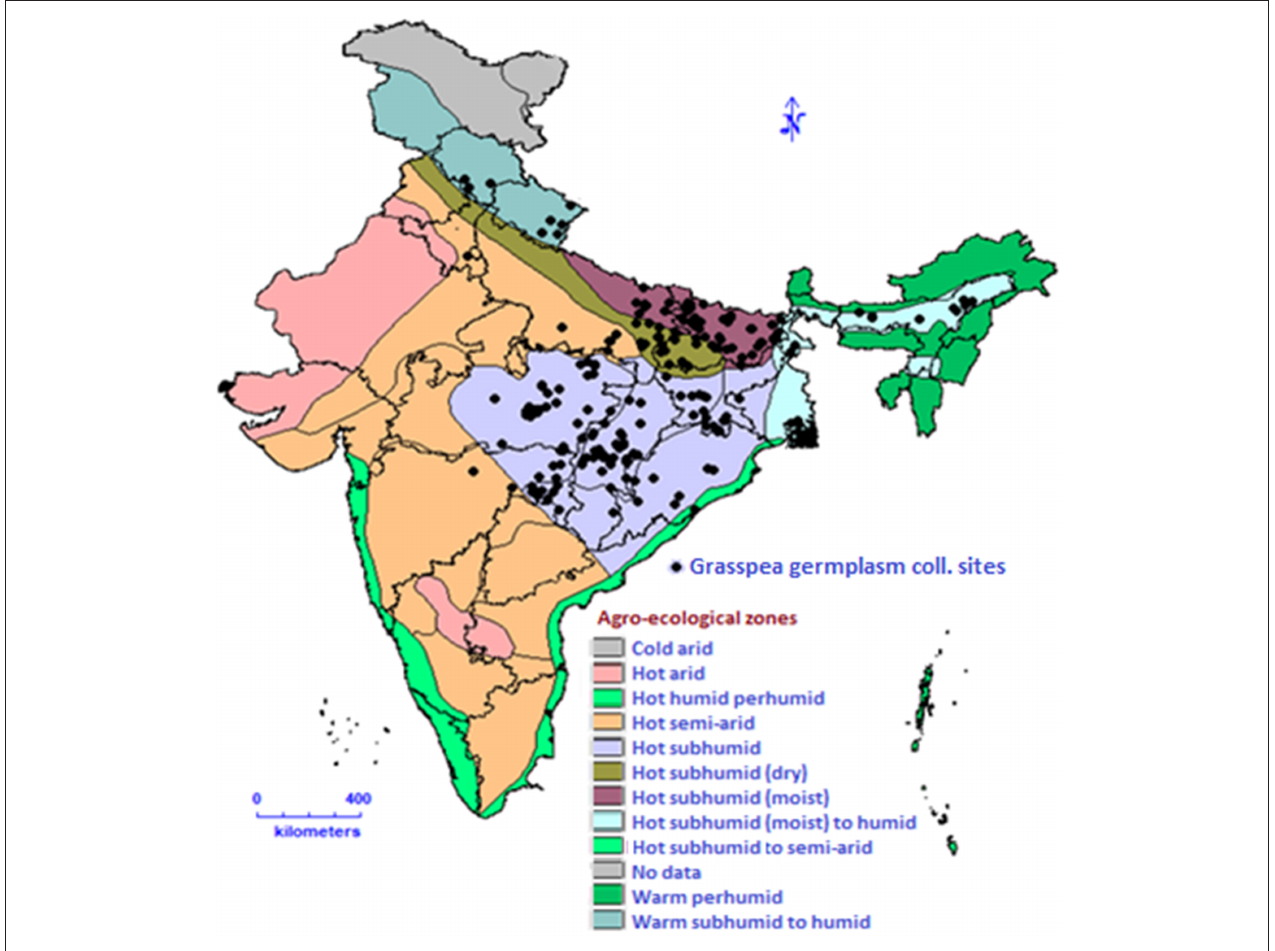
FIGURE 4 | Grasspea germplasm collecting sites in India.